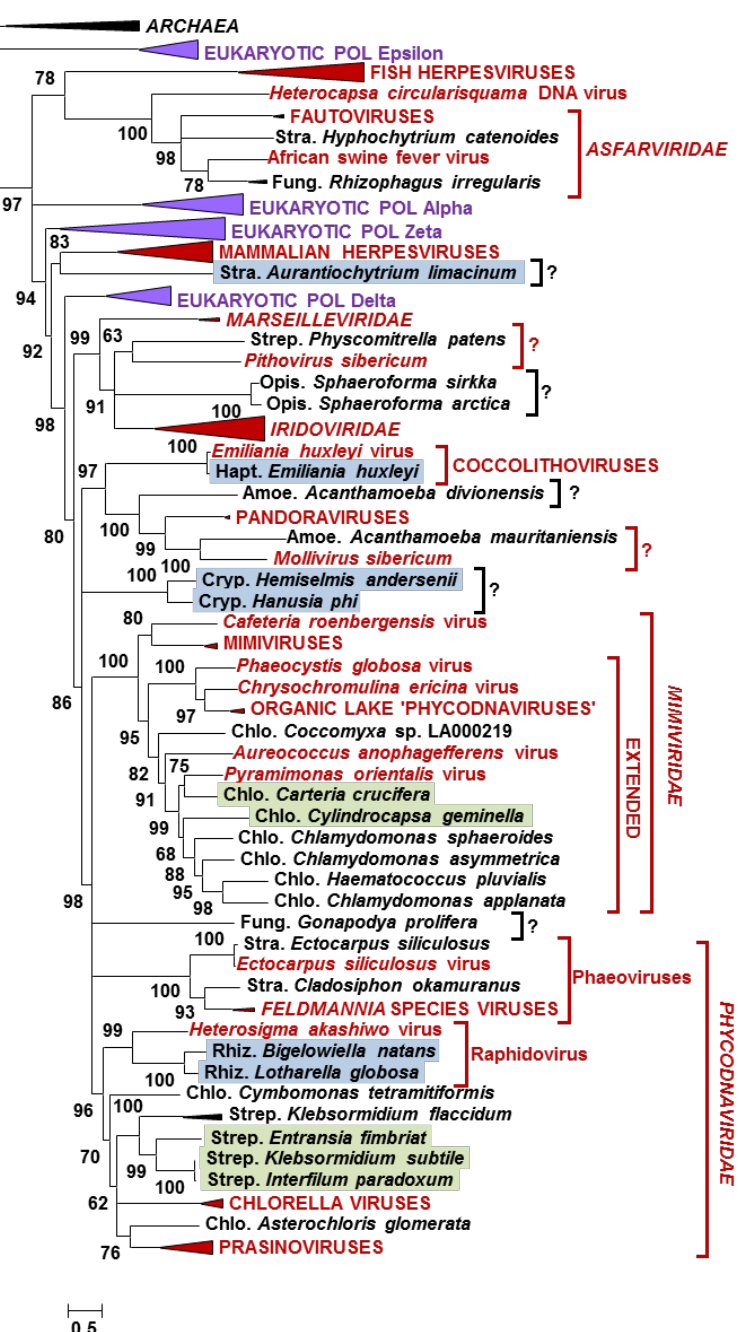
Figure 1. Maximum likelihood phylogenetic tree of DNA polymerase proteins. Statistical supports for branch (SH-like local support test) are given above or below nodes in percent. Branches with support less than 50% were collapsed. Species names with colored background indicate transcribed genes: green, 1KP transcriptomes; blue, MMETSP transcriptomes. Red and black question marks show potential extension of recognized viral groups or new viral clades, respectively. The scale bar indicates the number of substitution per site. Sequences, alignments, and phylogenetic trees are available in Dataset S1.